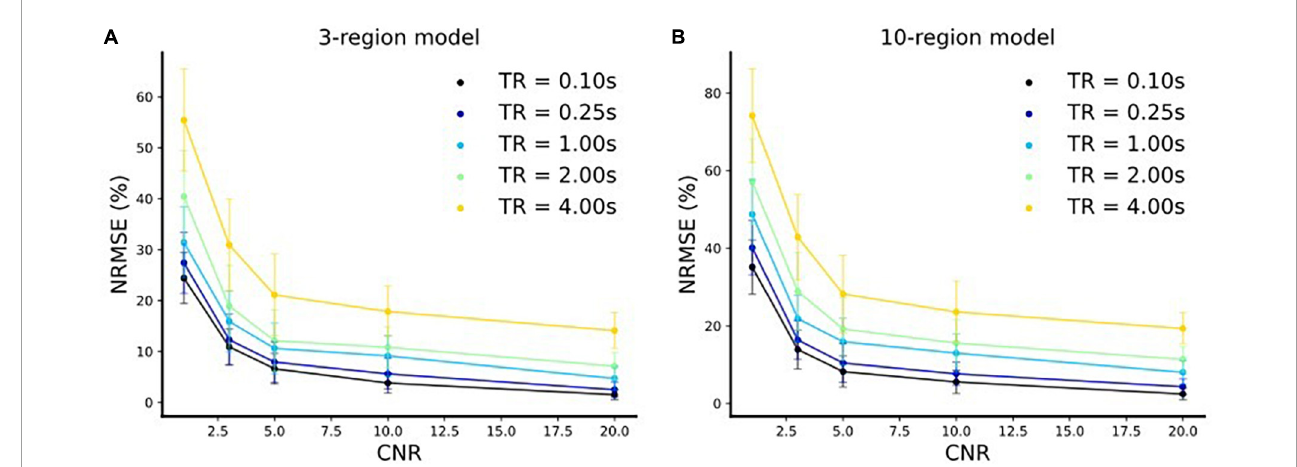
FIGURE8 Normalized Root Mean Squared Error (NRMSE) (mean ± s.d.) expressed as a % vs. CNR for. (A) Three-region model and (B) 10-region model for five different repetition time (TR) settings.